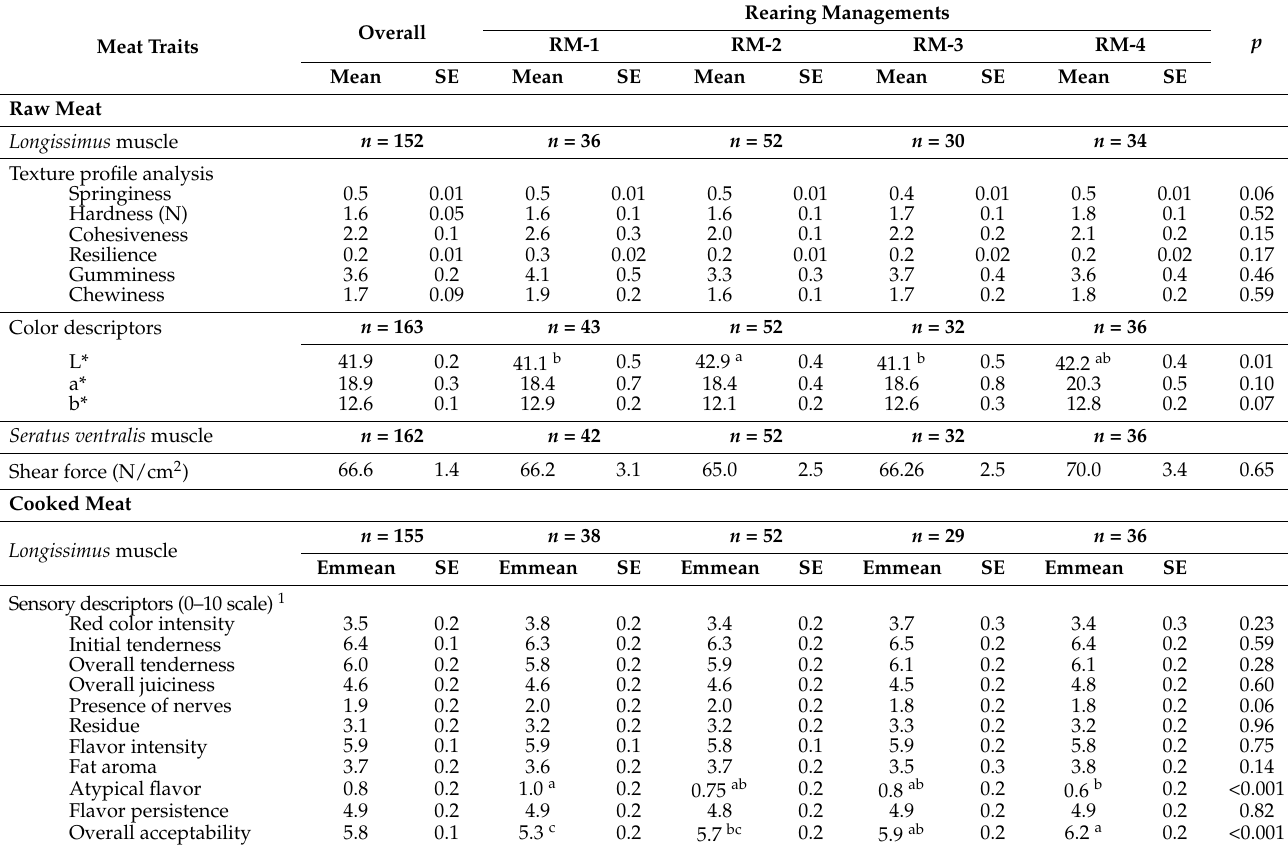
Table 6. Effects of the four rearing managements (RM) applied during the whole heifers’ life factors on the meat